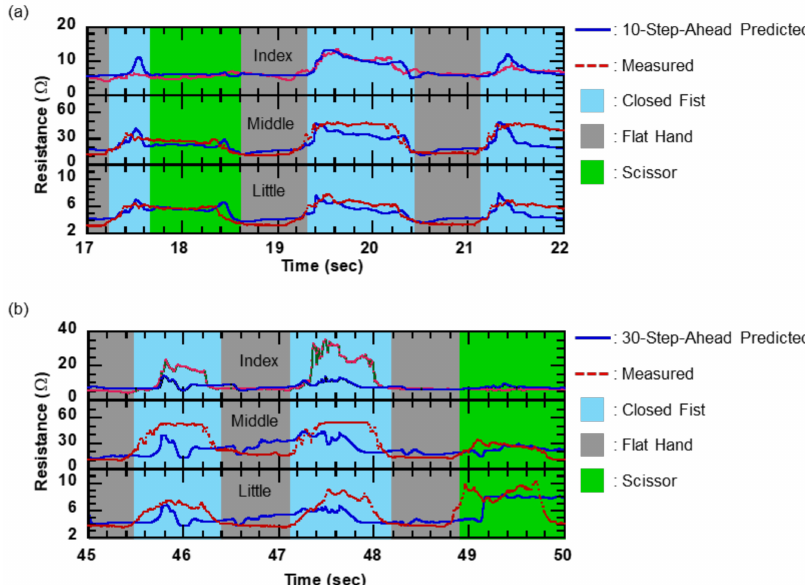
Figure 8. Relation between measured resistance data and ( a ) 10-step-ahead and ( b ) 30-step-ahead predicted resistance using TDNN model. The blue solid and red dashed lines represent predicted and actual data, respectively.